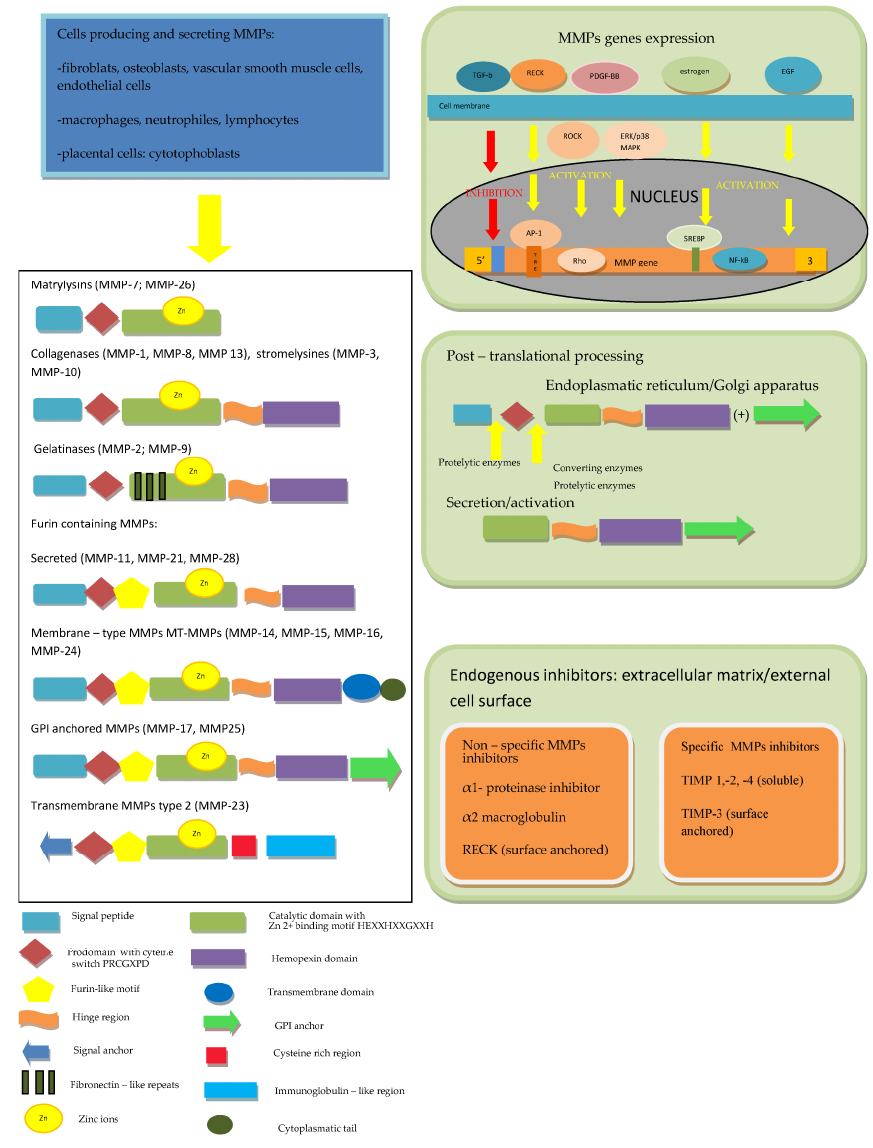
Figure 1. The MMPs’ structure and multifactorial and multi-level regulation of MMPs. According to [1,2,4,6,15–17,20,25].